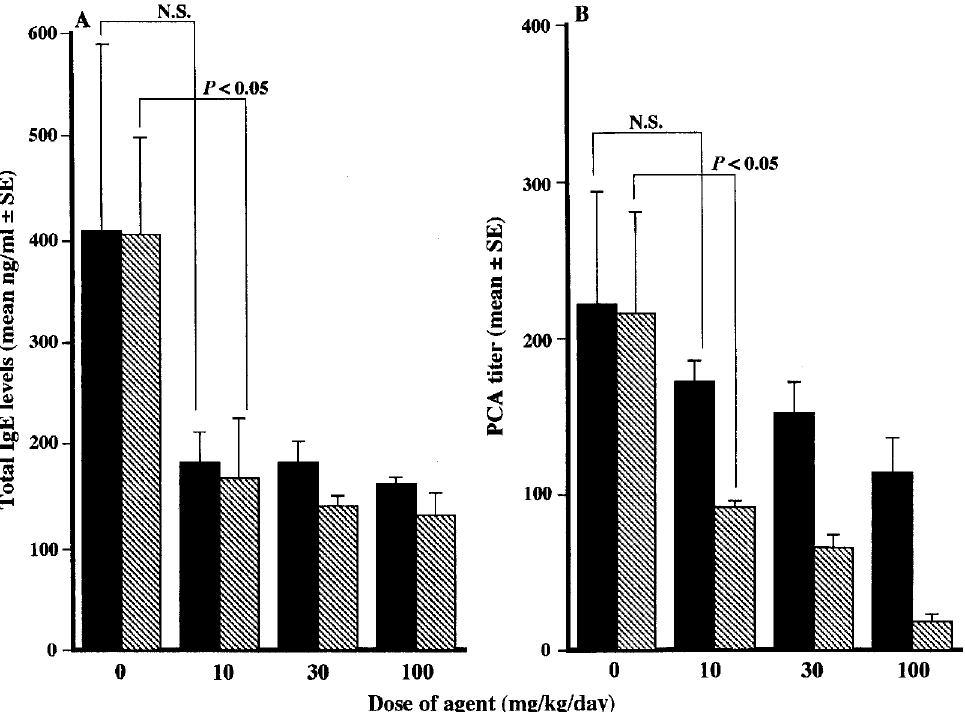
FIG. 6. Influence of IPD–1151T on total (A) and specific (B) IgE concentrations in serum prepared from BALB/c mice sensitized with DNP-KLH. All mice were injected intraperitoneally with 5 m g of DNP-KLH mixed with Al(OH) 3 . The mice were administered orally with IPD–1151T for either 5 (starting on Day 9) ( j ) or 14 (starting on Day 0) ( ) days from the day of sensitization. Serum was prepared from five individual mice on Day 15, 24h after final drug administration.